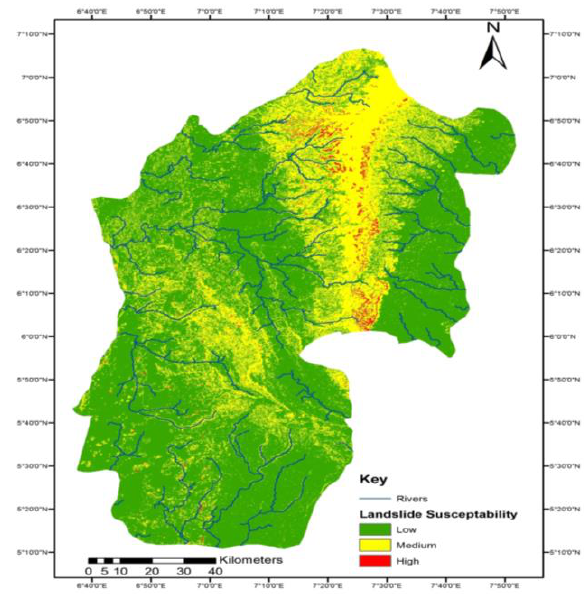
Figure 9: Landslide susceptibility Map of the Study